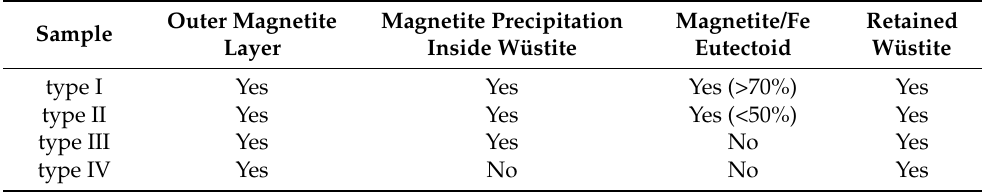
Figure 1. Microstructure cross-section images of oxide scales: ( a ) type I; ( b ) type II; ( c ) type III; ( d ) type IV. Table 3. Microstructure characteristics of oxide scales.